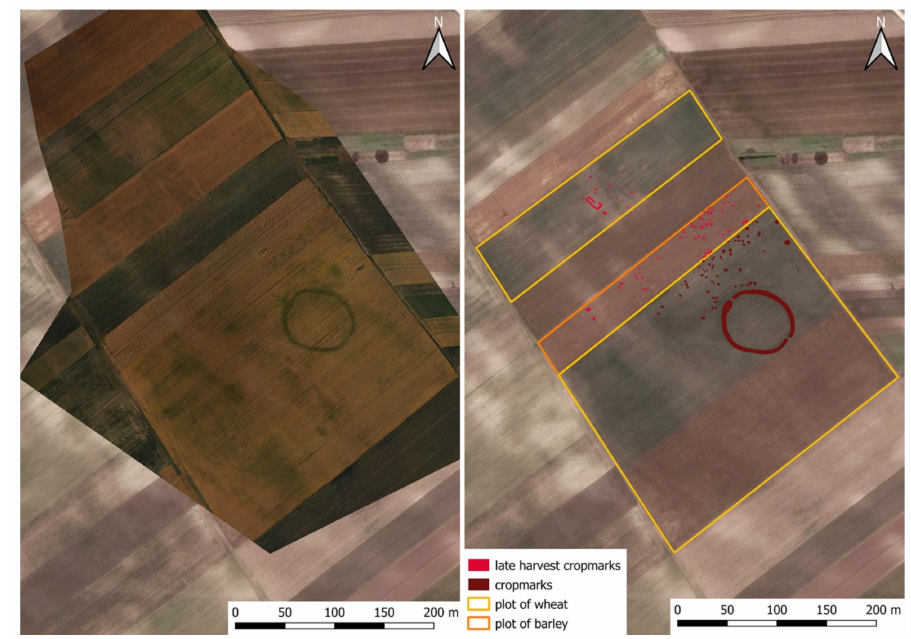
Figure 2. Rectified oblique aerial photographs at Dabas—Öreg Orsz á g ú ti-d˝ul˝o (Pest County, Hungary, cf. Figure 1). Aerial photo polygons are generally related to the parcel-system. The “normal”/late harvest cropmarks are marked in different colors. Source: Zolt á n Czajlik, 12 June 2015 and